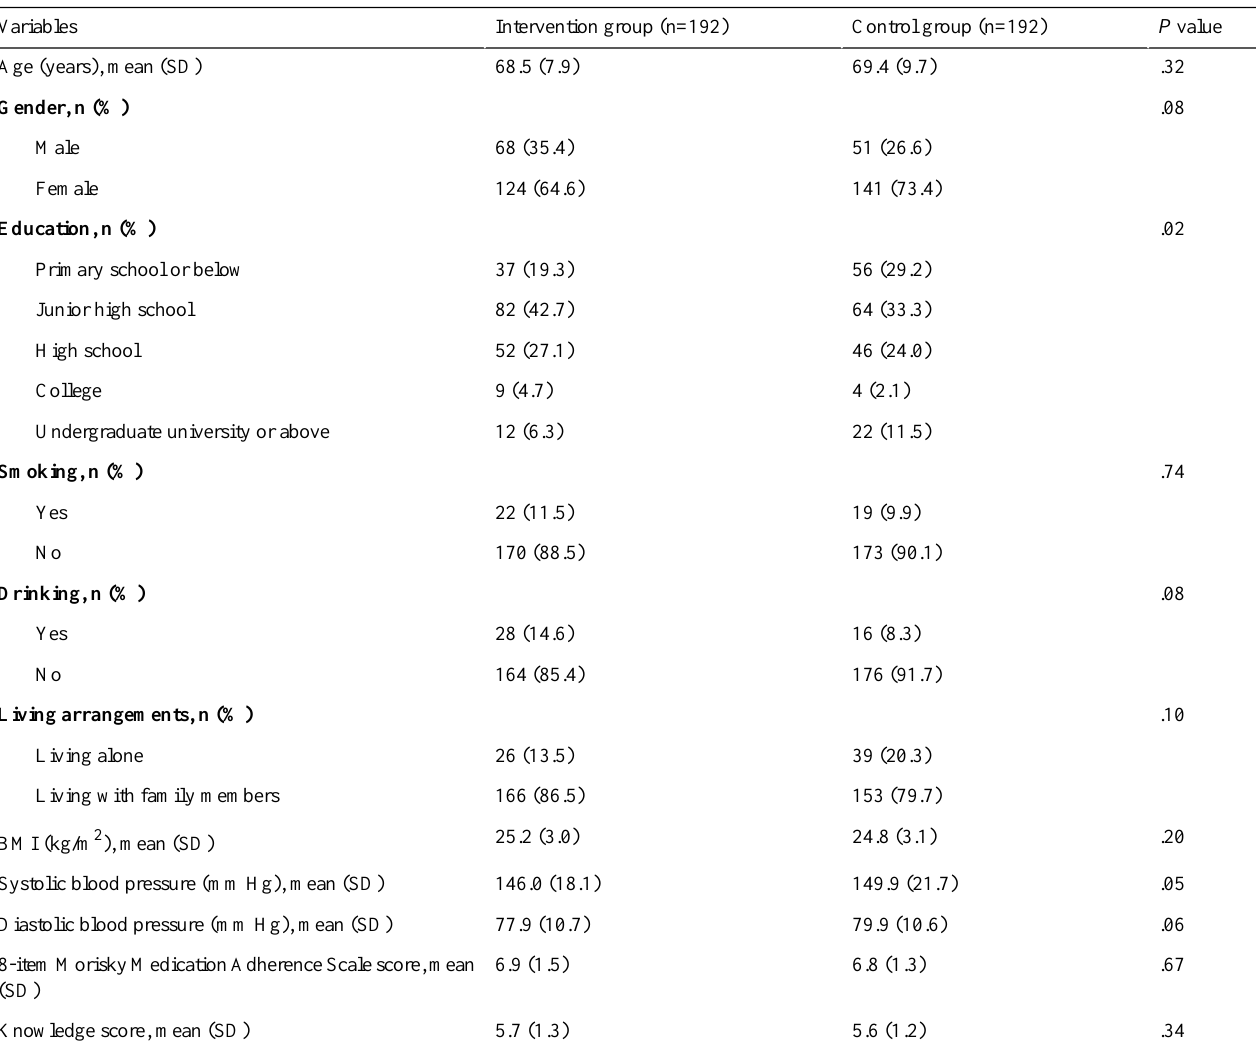
Table 2. Baseline characteristics of participants